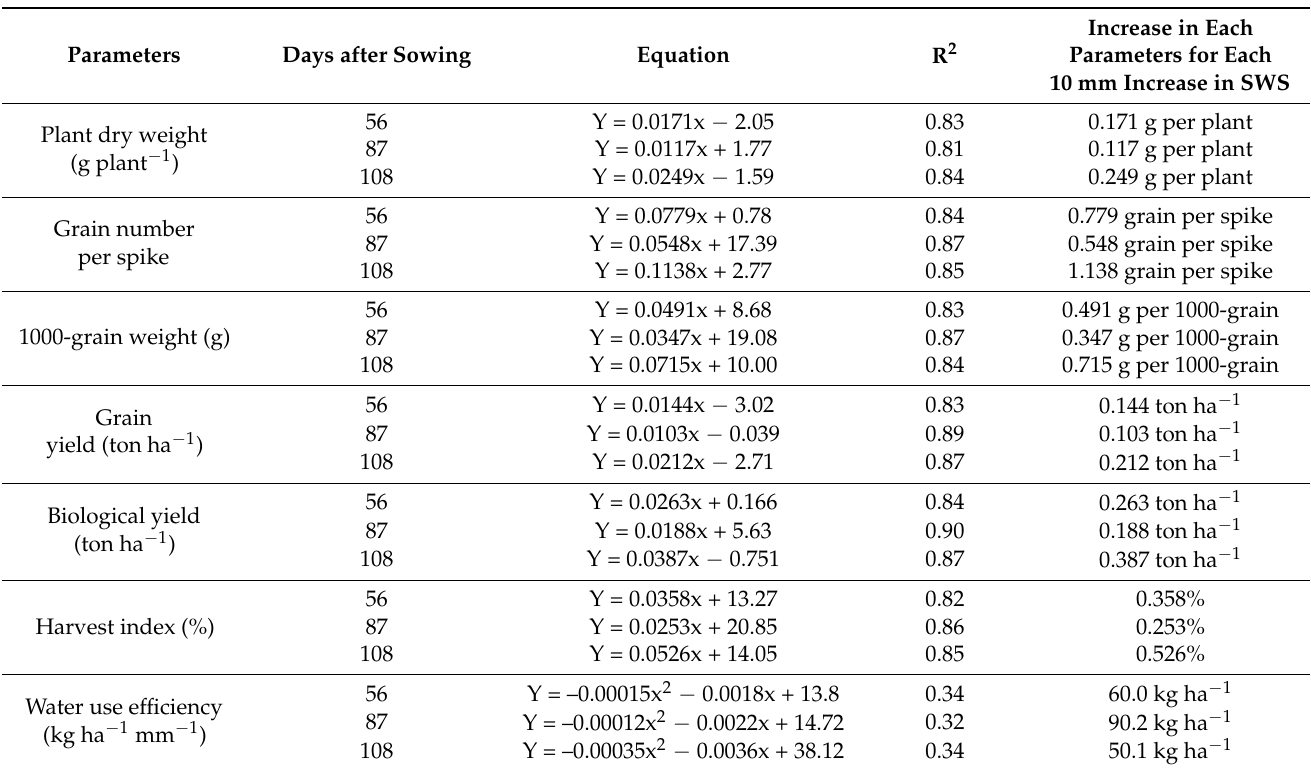
Table 4. Functional relationship between different measured wheat parameters (Y) and total soil water storage in the 0–60 cm soil layer (x) measured before